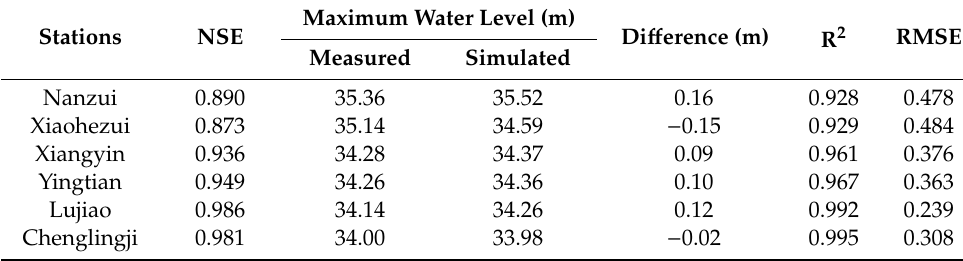
Table 1. The Nash–Sutcliffe efficiency coefficients (NSE), R 2 and the root mean square error (RMSE) calculated at the main hydrological stations in Dongting Lake.